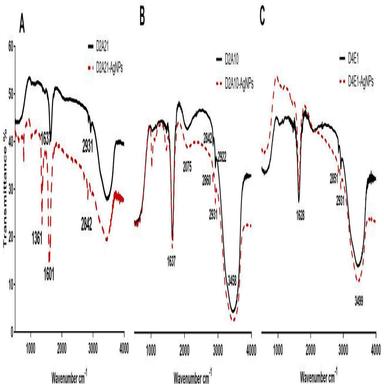
Fourier transform infrared spectroscopy (FTIR) spectrum of P-AgNPs and native peptides. Native D2A21 and D2A21-AgNPs (A); native D2A10 and D2A10- AgNPs (B); native D4E1 and D4E1-AgNPs (C).